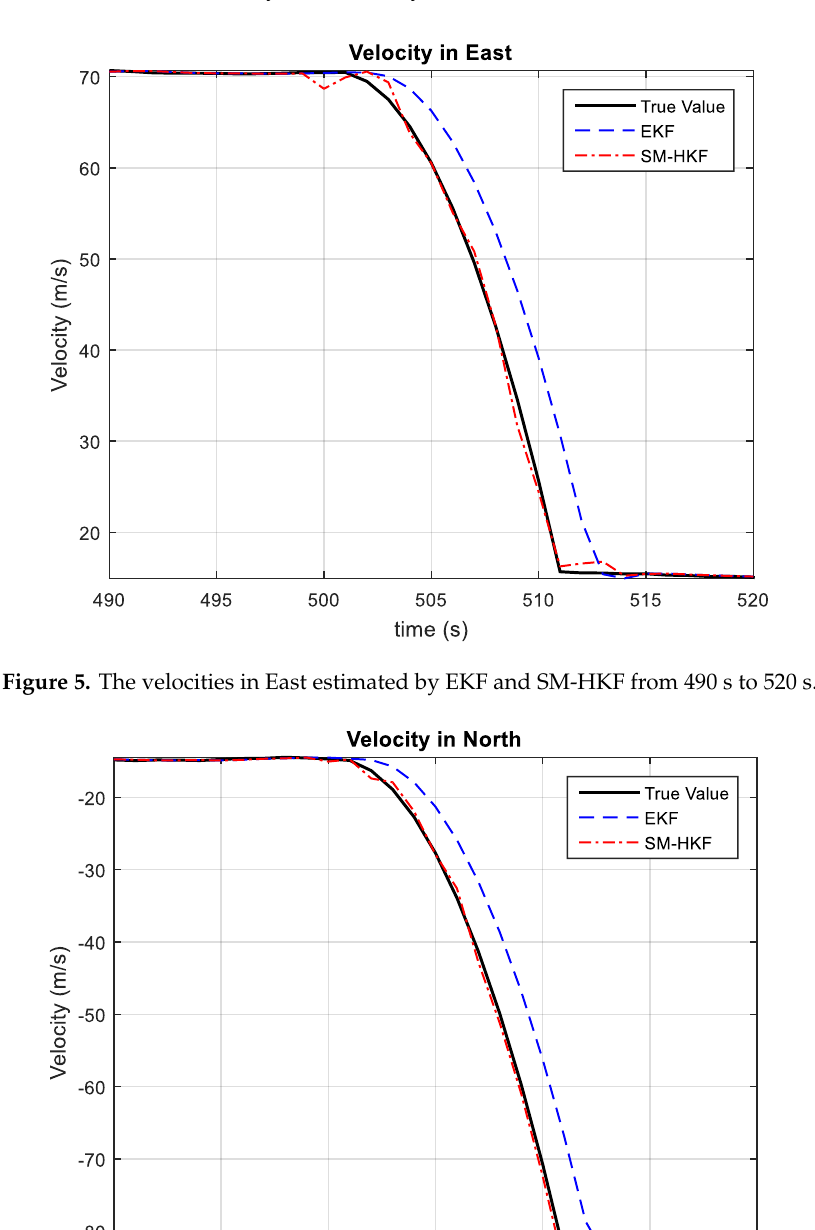
Figure 4. The positions in North estimated by EKF and SM-HKF.